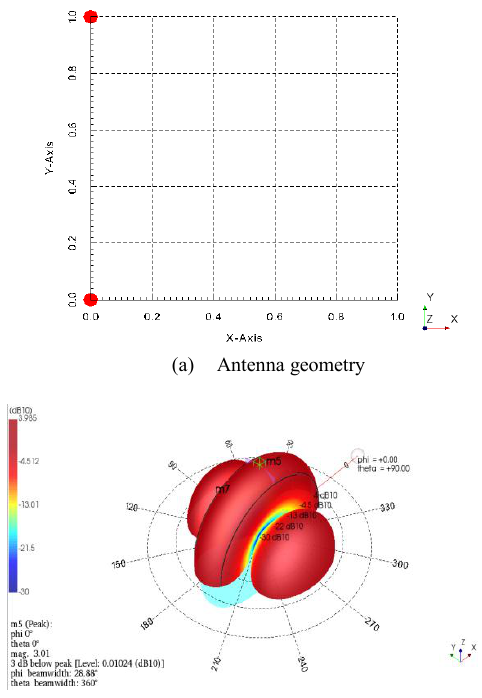
Figure 9. Linear antenna array (N=2, dy = 1 λ , βy = 0°)